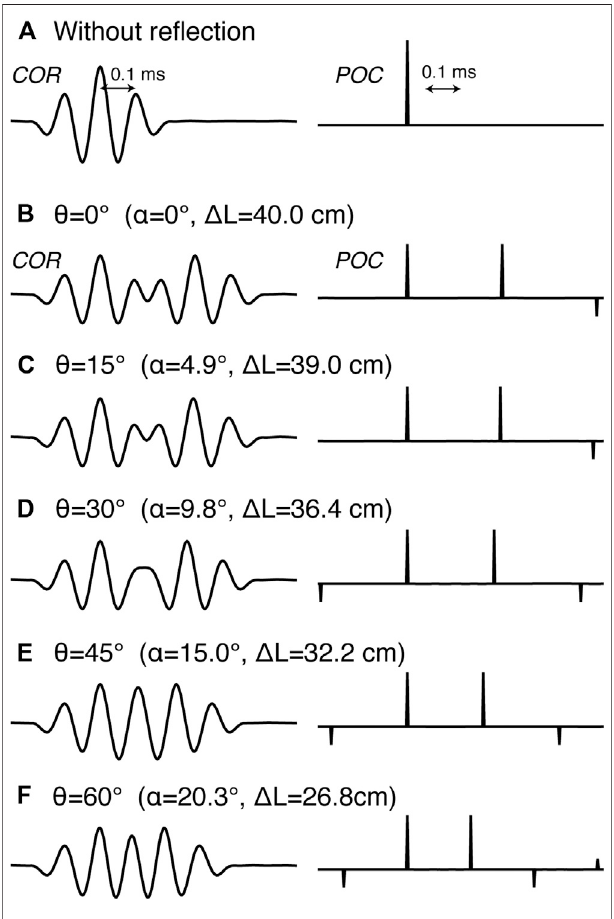
FIGURE 11 | Cross-correlation (left) and POC (right) between the reference signal and simulated signals superimposed by re fl ected waves, calculated for incident angles θ (cid:2) 0 ° , 15 ° , 30 ° , 45 ° , 60 °